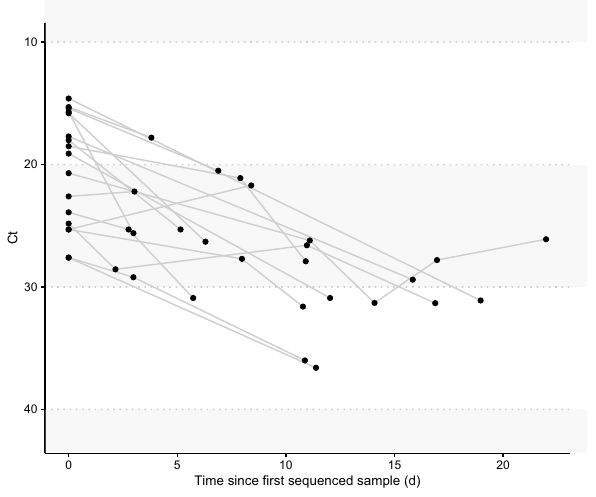
Figure 1. Viral load dynamics in sequenced samples. Dots represent a unique sequenced sample. Lines connect samples from a single patient. Same day samples are not shown (see Supplementary Fig.